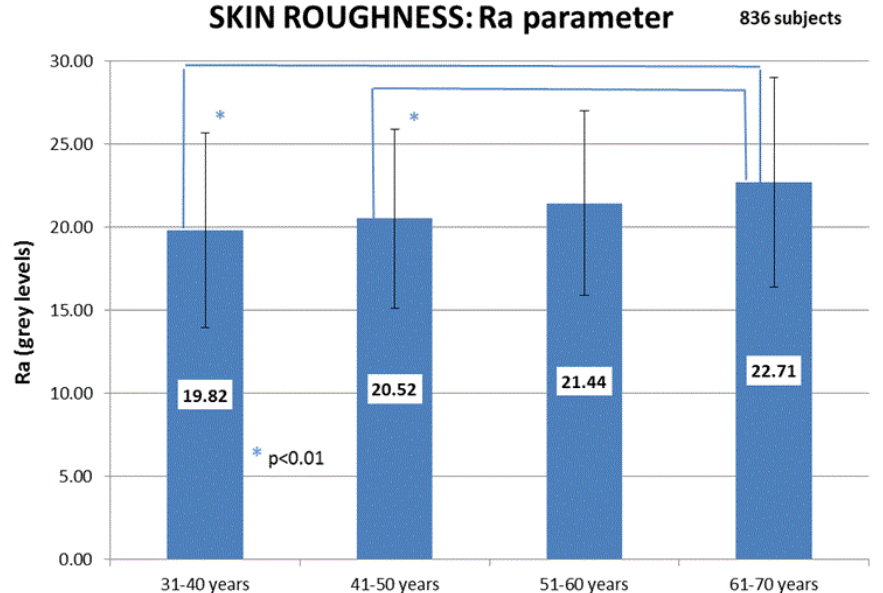
Figure 5. Skin roughness basal values (Ra parameter) as a function of the age group. Statistical comparison among the age groups: * p < 0.01 (31–40 vs. 61–70 years; 41–50 vs. 61–70